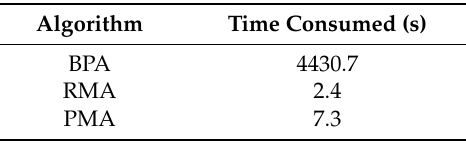
Table 2. Time consumed by each algorithm.